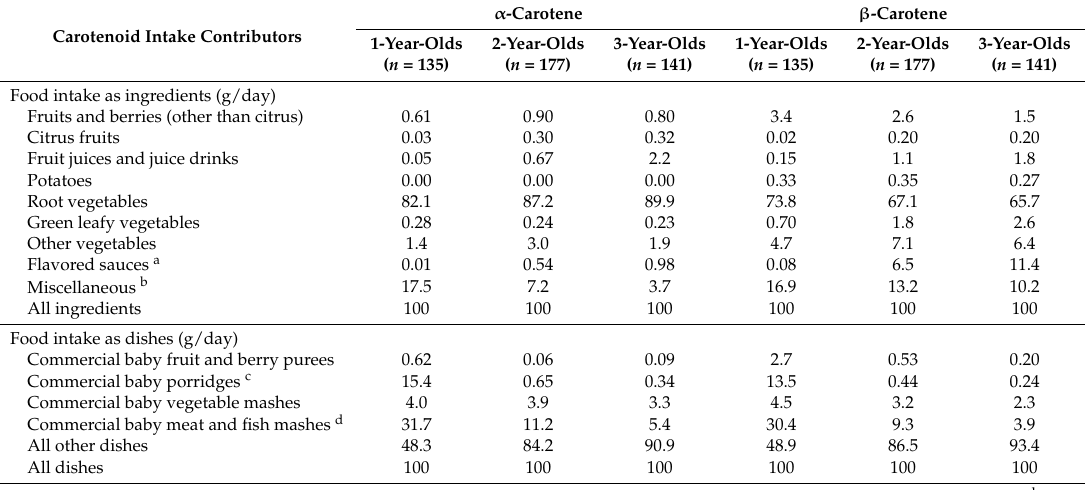
Table 3. Proportional contribution (%) of dietary sources to the intake of α - and β -carotene by age